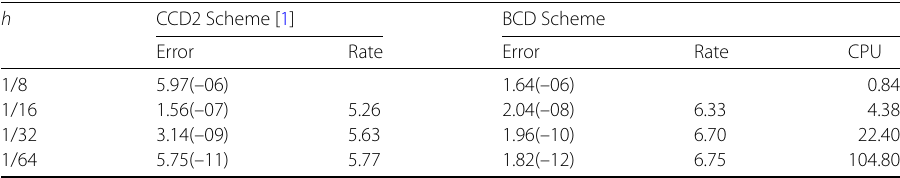
Table 1 The maximum absolute error and convergence rate of different discretization for Problem 1 h CCD2 Scheme [1] BCD Scheme Error Rate Error Rate CPU 1/8